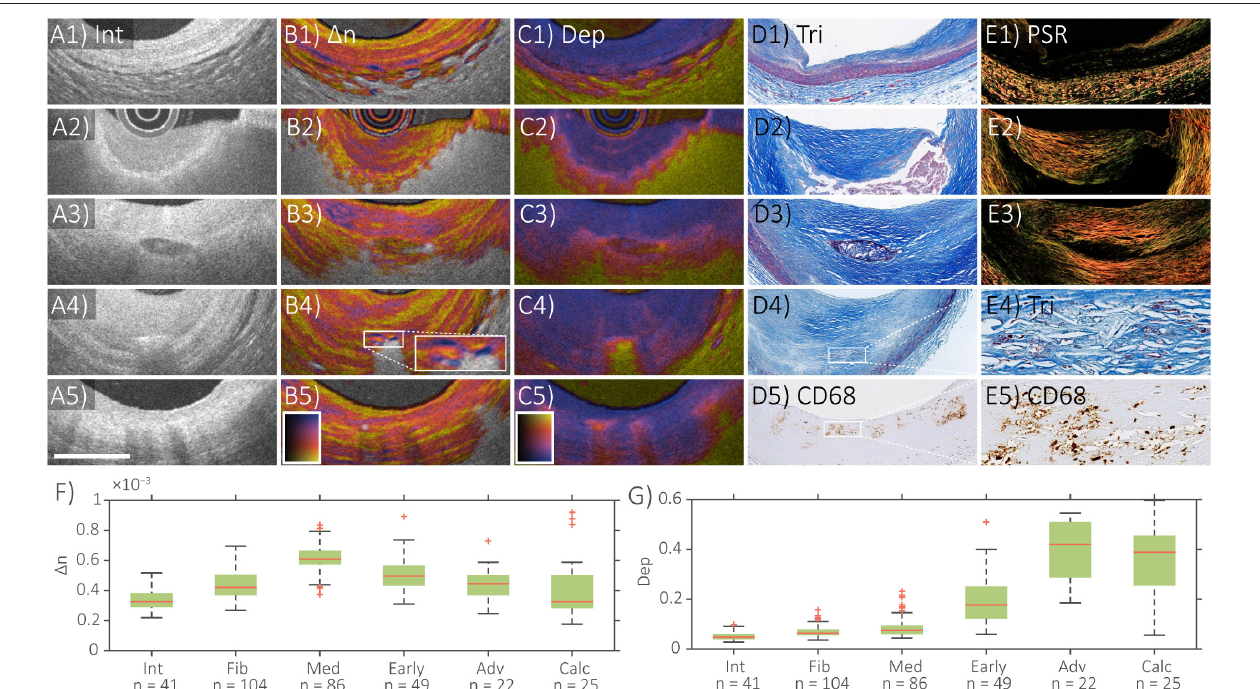
FIGURE 2 | Distinct polarization features of atherosclerotic human coronary arteries ex vivo . IVP of (A1–E1) normal artery, (A2–E2) fibroatheroma, (A3–E3) fibrocalcific plaque, (A4–E4) cholesterol crystals, and (A5–E5) macrophages, with matching histology. (F) Median and quartile birefringence ( 1 n) values in regions with depolarization < 0.2 across tissue types. (G) Median and quartile depolarization (Dep) values across tissue types. Scale bar, 1mm. Int, intensity; 1 n, birefringence; Dep, depolarization; Tri, trichrome staining; PSR, Picrosirius red staining; In (F), Int, intima; Fib, fibrous tissue; Med, tunica media; Early, early lesions with dispersed lipid; Adv, advanced lesions with lipid pools or necrotic core; Calc, calcifications. Adapted from Villiger et al. (34) and Otsuka et al. (36).